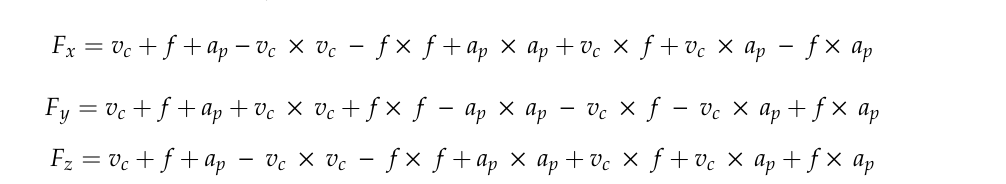
Figure 11. Optimization Plot for Minimum Cutting Force of F x , F y , F z SiCp / Al. Regression Equation for F x , F y , and F z SiCp / Al